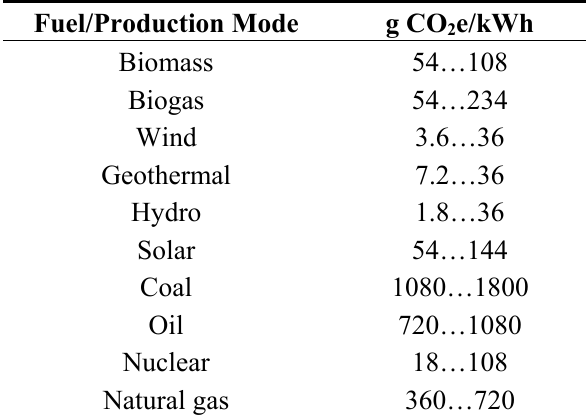
Table 3. GHG intensities for certain electricity and cogeneration technologies and fuels from Cherubini et al. (2009)